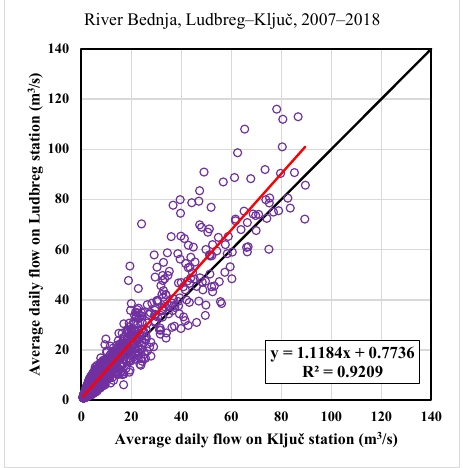
Figure 9. Comparison of the correlation between the measuring stations Ludbreg and Klju č .